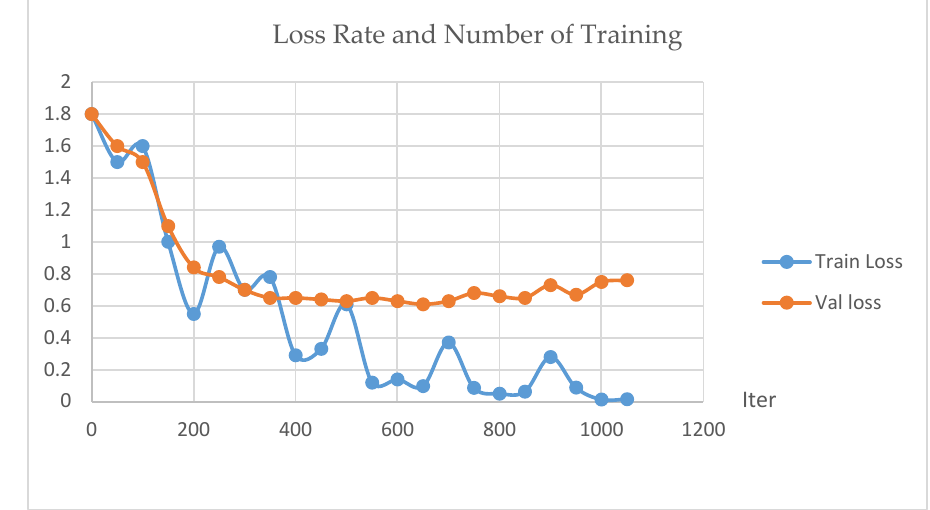
Figure 7. Loss rate and number of trainings.